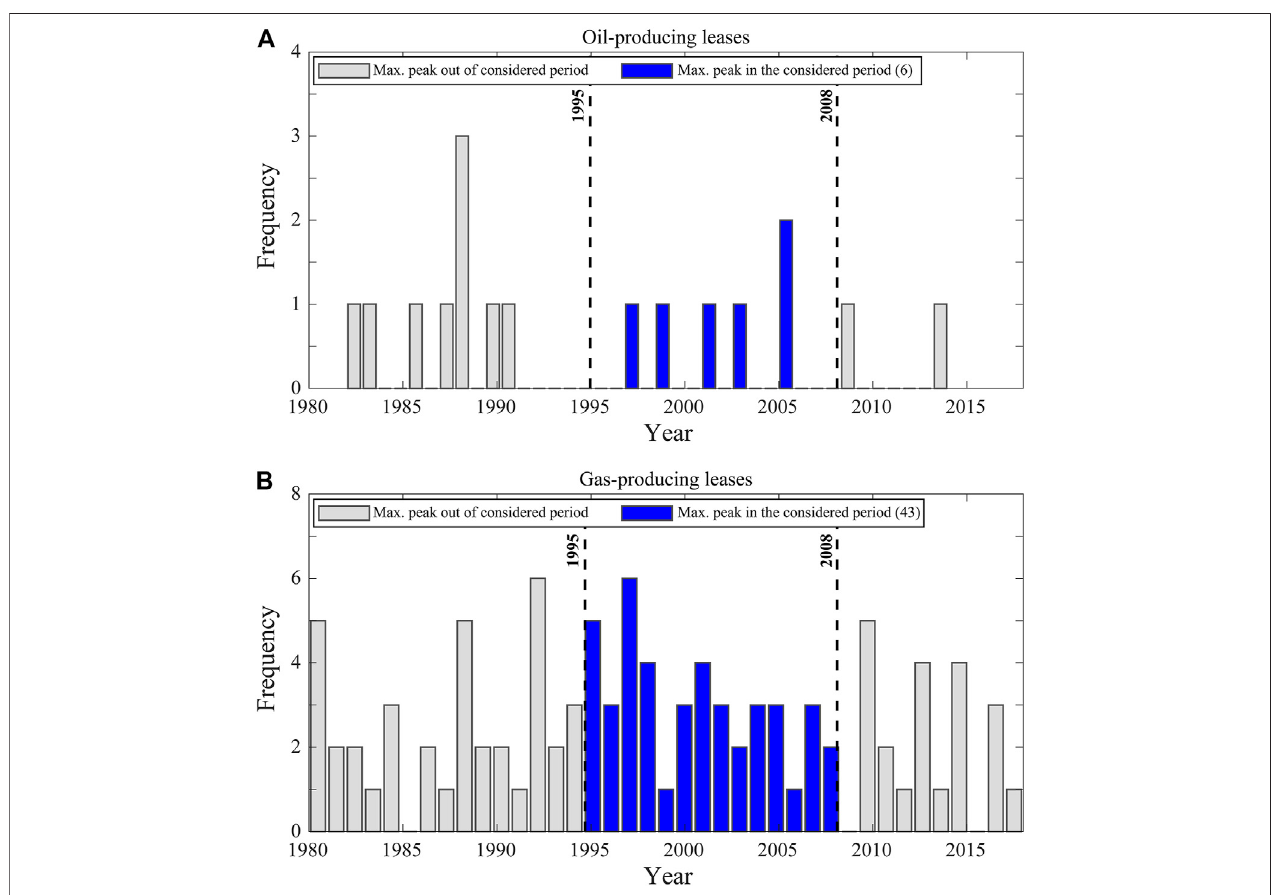
FIGURE4| Yearatwhichthemaximumproductionisreachedintheavailabledataateachdevelopmentlease( t m ).Histogramsshowsthenumberof (A) oil-and (B) gas-producing leases in which t m is reached in the respective year; the blue bars identify the period selected for the analyses (1995 – 2008) according to the described